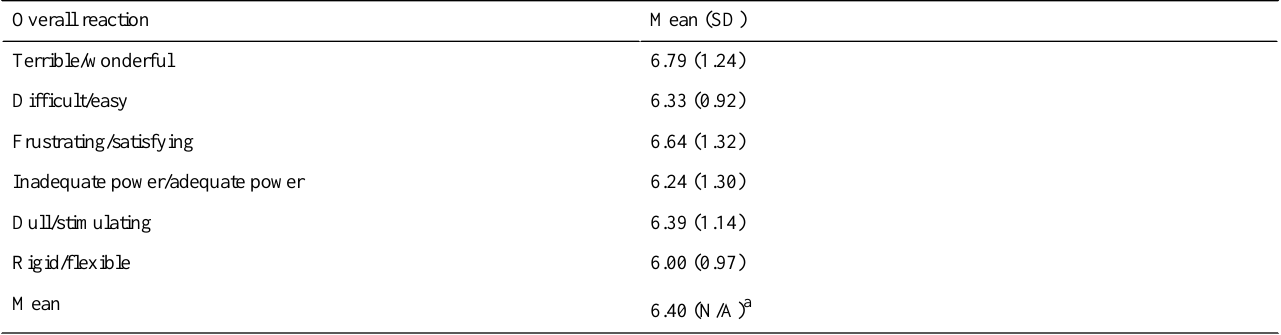
Table 2. Overall responses of patients with type 2 diabetes to the six